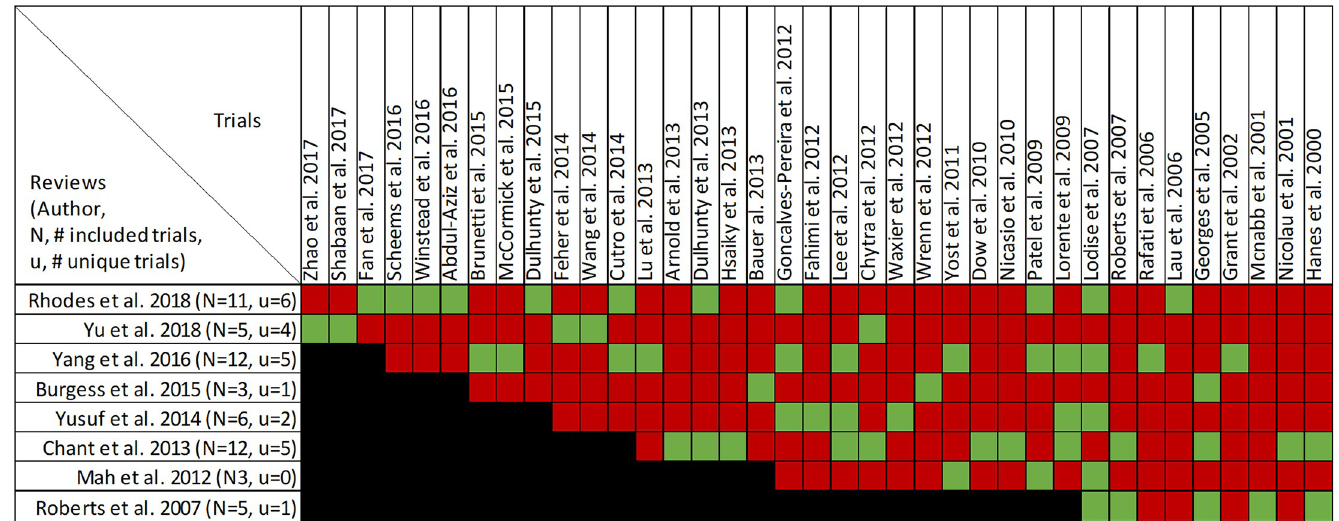
Fig 12. Citation matrix for reviews reporting length of stay of prolonged infusions versus intermittent infusions of beta-lactams. Green—primary studies included in systematic review, Red—primary study not included in systematic review, Black—primary studies published after systematic review and therefore ineligible for possible